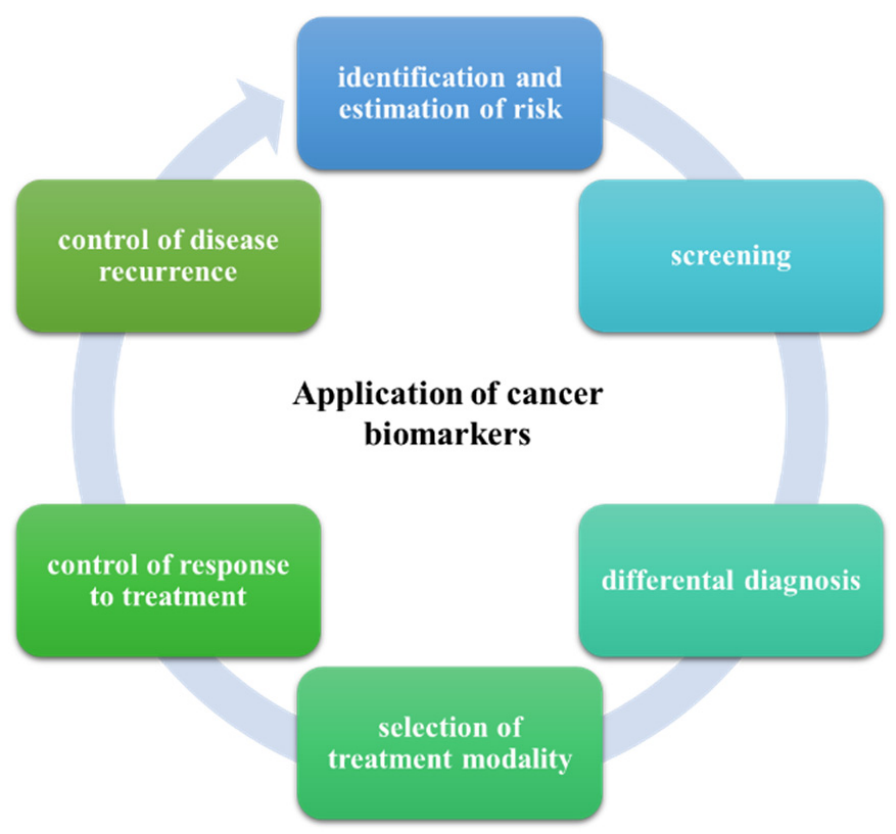
Figure 1. Exemplary applications of cancer biomarkers for clinical and medical purposes (based on [13,14]).